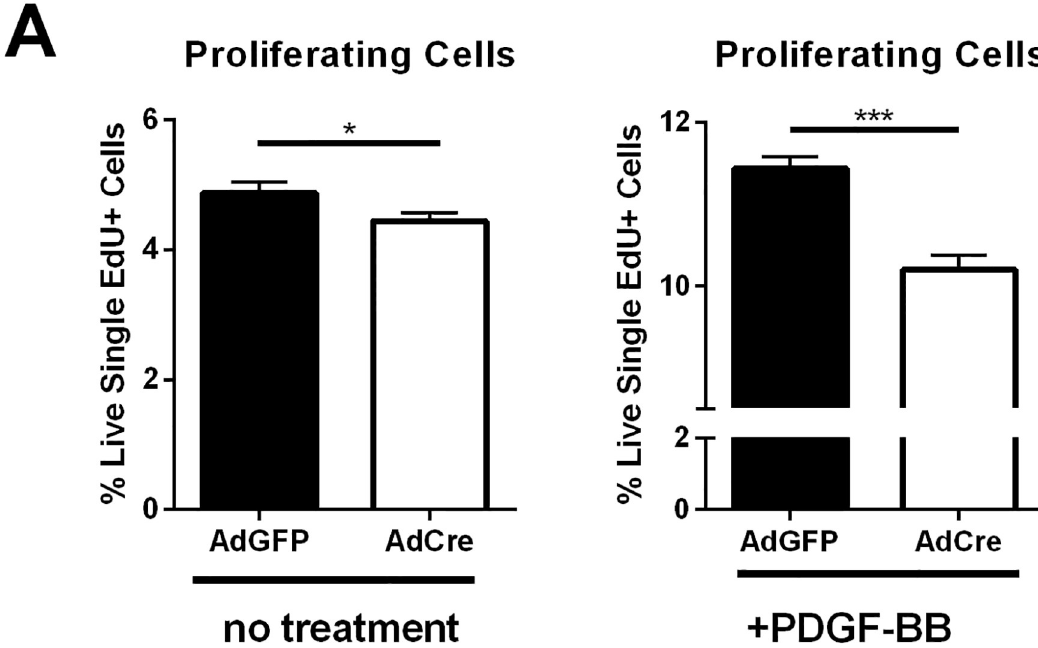
Fig 5. PDGFR β is required for robust periosteal proliferation in vitro in cells derived from gCbl YF mice. (A) Periosteal cells isolated from PDGFR FL/FL ; gCbl YF mice were cultured for four days, and then serum starved and infected with AdCre or AdGFP overnight (MOI = 300). Cells were treated with EdU (10mM) for four hours prior to isolation and staining. Flow cytometry analysis of EdU+ periosteal cells in vitro shows significantly less proliferation in periosteal cells following AdCre-mediated deletion of PDGFR β on the gCbl YF background, without PDGF addition. N = 3 � p < 0.05 (B) Periosteal cells isolated from PDGFR FL/FL ; gCbl YF mice were cultured for four days, and then serum starved and infected with AdCre or AdGFP overnight (MOI = 300). Cells were then treated with PDGF-BB and EdU (10mM) for four hours prior to isolation and staining. Flow cytometry analysis of EdU + periosteal cells in vitro shows significantly less proliferation in periosteal cells treated with PDGF-BB following AdCre-mediated deletion of PDGFR β on the gCbl YF background. N = 3 ��� p <